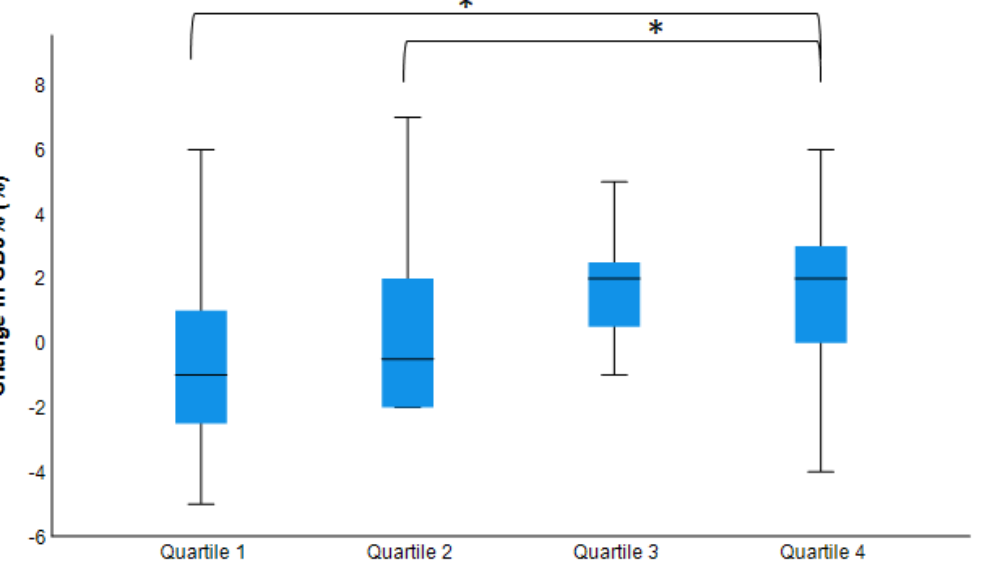
Figure 3. Changes in CD3 + % by serum 25(OH)D changes (post- vs. pre-intervention values). Model adjusted for baseline value, age, sex, BMI, and seasons of the year (n = 50). Bar plot shows median with IQR and standard deviation from mean. Group 1 had the lowest quartile delta change in 25OHD and Group 4 had the highest. *Mean change for Group 4 was significantly different from Groups 1 and 2, but not with Group 3 ( p -values < 0.05). No significant differences found among Groups 1 through 3.